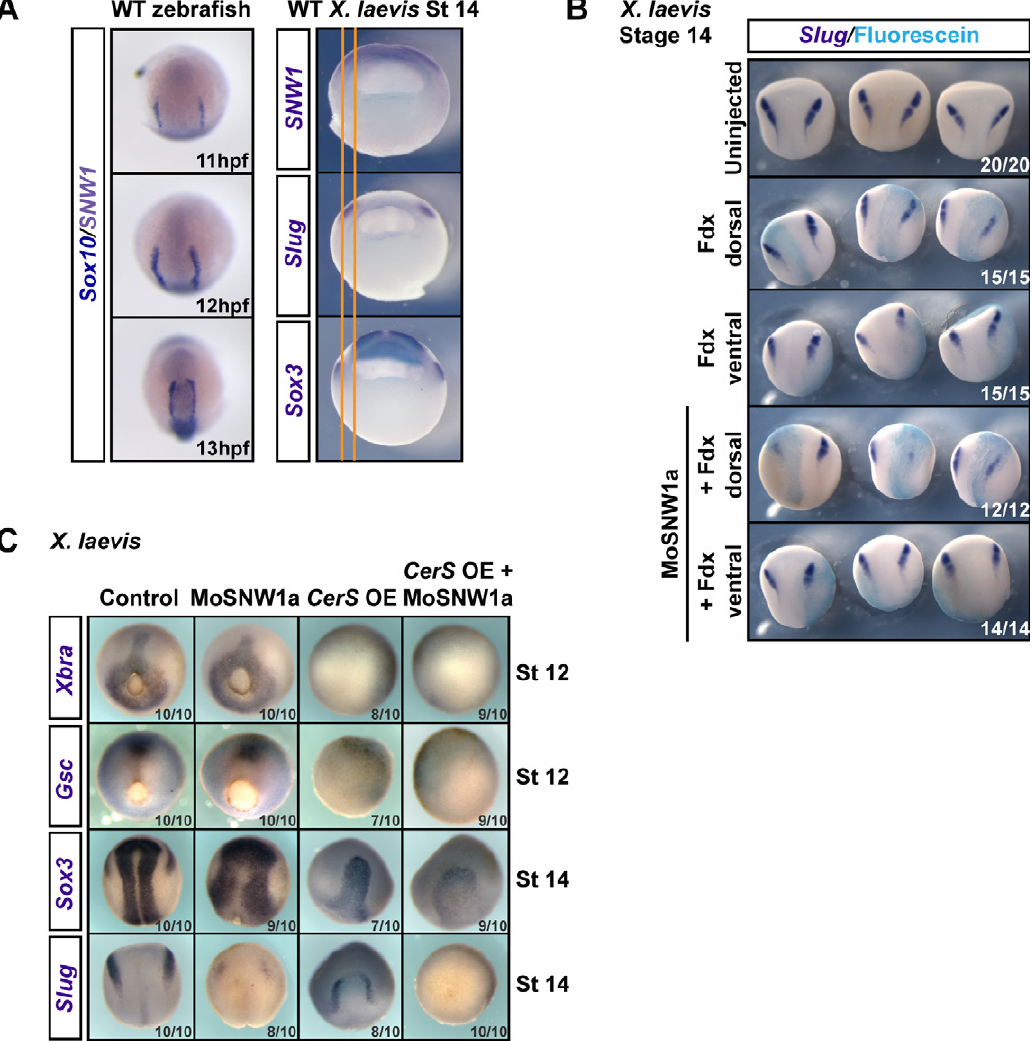
Figure 3. Dorsally expressed SNW1 is required for neural crest specification, and this is independent of mesoderm. (A) Left panels. Wild-type (WT) zebrafish embryos at the indicated times post-fertilization were doubly stained for the neural crest marker Sox10 (dark blue) and SNW1 (grey-purple), which is localized in the neural plate (see Figure 1F). Right panels. Wild-type stage 14 Xenopus embryos were stained for either SNW1 , the neural crest marker Slug or the neural plate marker Sox3 . The orange lines mark the edges of the neural crest staining to enable direct comparison of expression domains. (B) One dorsal or one ventral blastomere of four-cell Xenopus embryos was injected with Fdx with or without 10 ng of MoSNW1a, as indicated. At stage 14 the embryos were stained for Slug and fluorescein. (C) Xenopus embryos were either uninjected (control), injected with 20 ng of MoSNW1a at the one-cell stage, injected with 250 pg of CerS mRNA into all four blastomeres at the four-cell stage, or injected with MoSNW1a at the one-cell stage followed by CerS mRNA at the four-cell stage. WISH was carried out for the mesoderm markers Xbra and Gsc at stage 12, or the neural plate marker Sox3 and the neural crest marker Slug at stage 14. OE, overexpression. In all cases the number of embryos out of the total analyzed that showed the presented staining pattern is